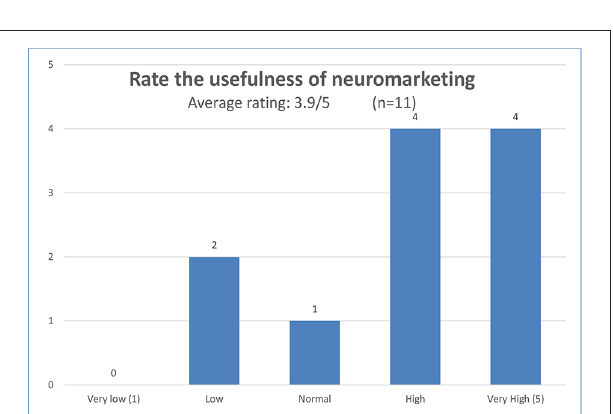
FIGURE 5 | Rate the usefulness of